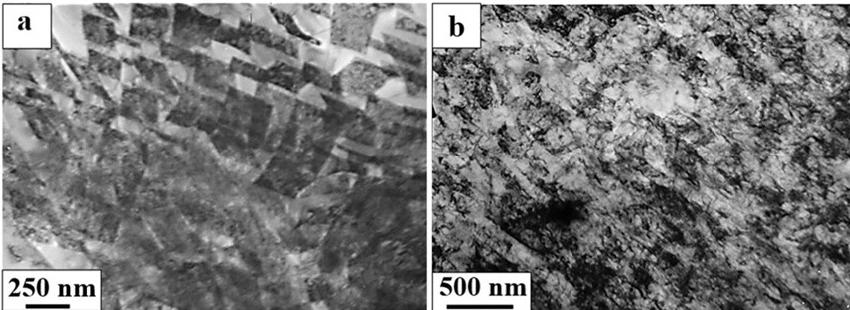
Figure 4. Structure of rail metal; a - fractured lamellar pearlite; b - ferrite-carbide mixture; a - layer at a depth of 2 mm; b - surface layer of fillet.